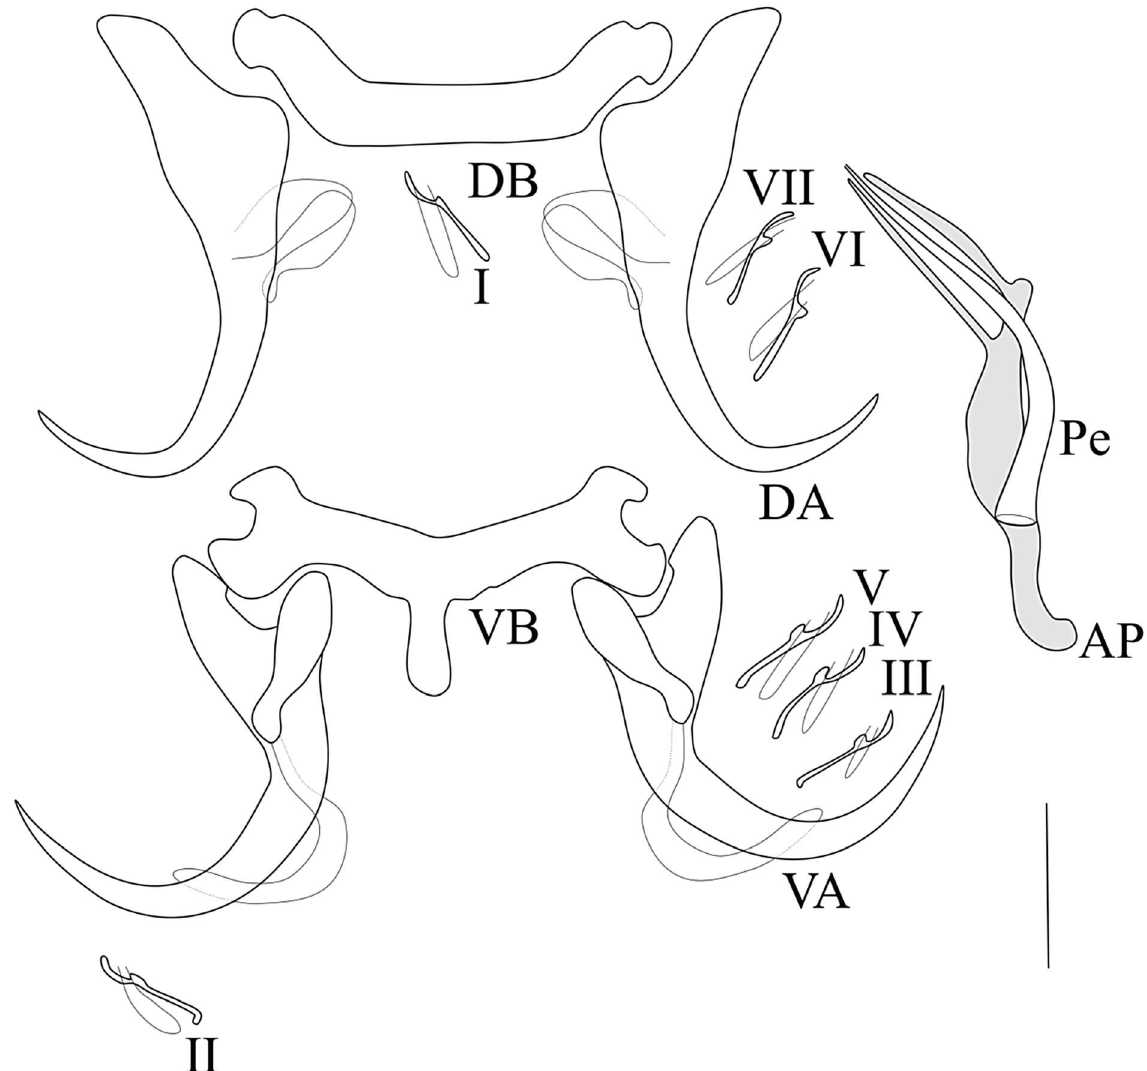
Figure 4. Sclerotized parts of Synodontella simplex n. sp. Scale bar = 20 l m. AP, accessory piece; DA, dorsal anchor; DB, dorsal bar; VA, ventral anchor; VB, ventral bar; Pe, penis; I-VII,